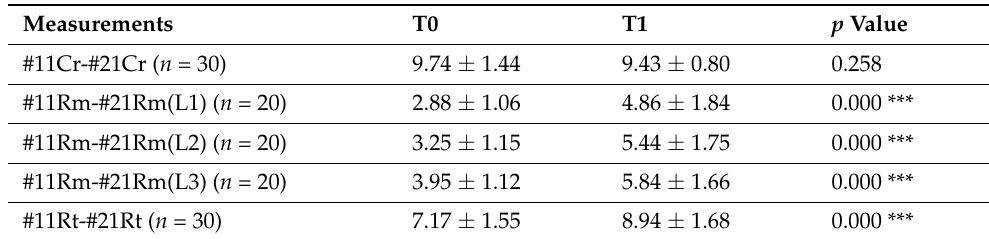
Table 4. Change in positional relationship between the maxillary central incisors after MARPE treatment (mean ± standard deviation).